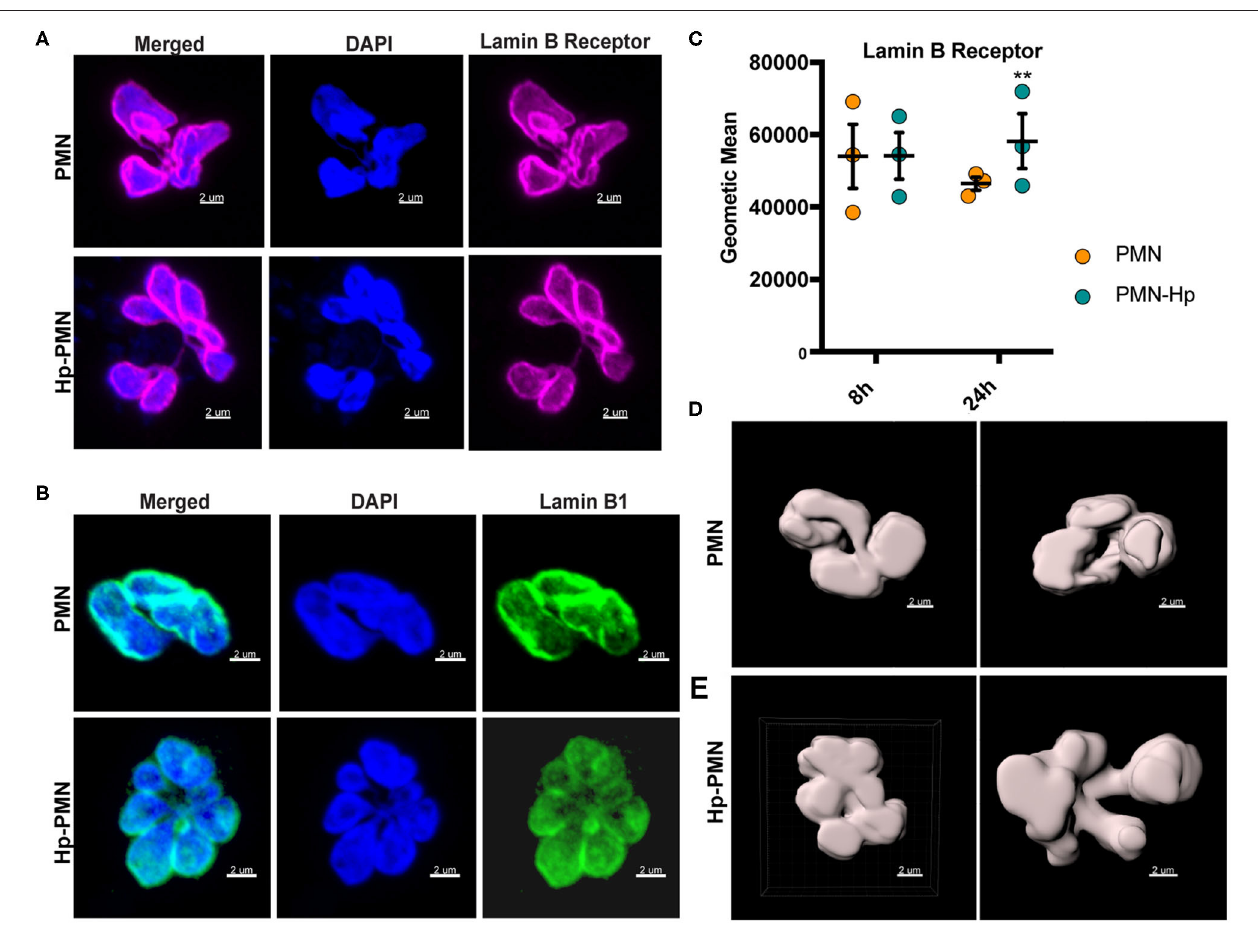
FIGURE 6 | H. pylori has no apparent effect LBR and lamin B1 localization or LBR abundance. (A,B) LBR (A) and Lamin B1 (B) confocal Z-stack reconstructions of uninfected and infected PMNs at 24h. DAPI was used to detect DNA (blue), Alexa Fluor 647-conjugated secondary antibodies were used to visualize LBR (magenta), Alexa Fluor 488-conjugated secondary antibodies were used to visualize lamin B1 (green). (C) LBR in control and infected PMNs at 8 and 24h was quantified using flow cytometry. Geometric mean fluorescence and standard error of the mean are shown. Two-way ANOVA and Tukey’s multiple comparison test were used to determine significance. ** P ≤ 0.01, n = 3. (D,E) LBR STED reconstruction and nuclear periphery tracing for surface rendering used to quantify nuclear volume in Figure 7 . (D) Two views of a single uninfected PMN. (E) Two different infected cells. Scale bar = 2 µ m (x1,000 original